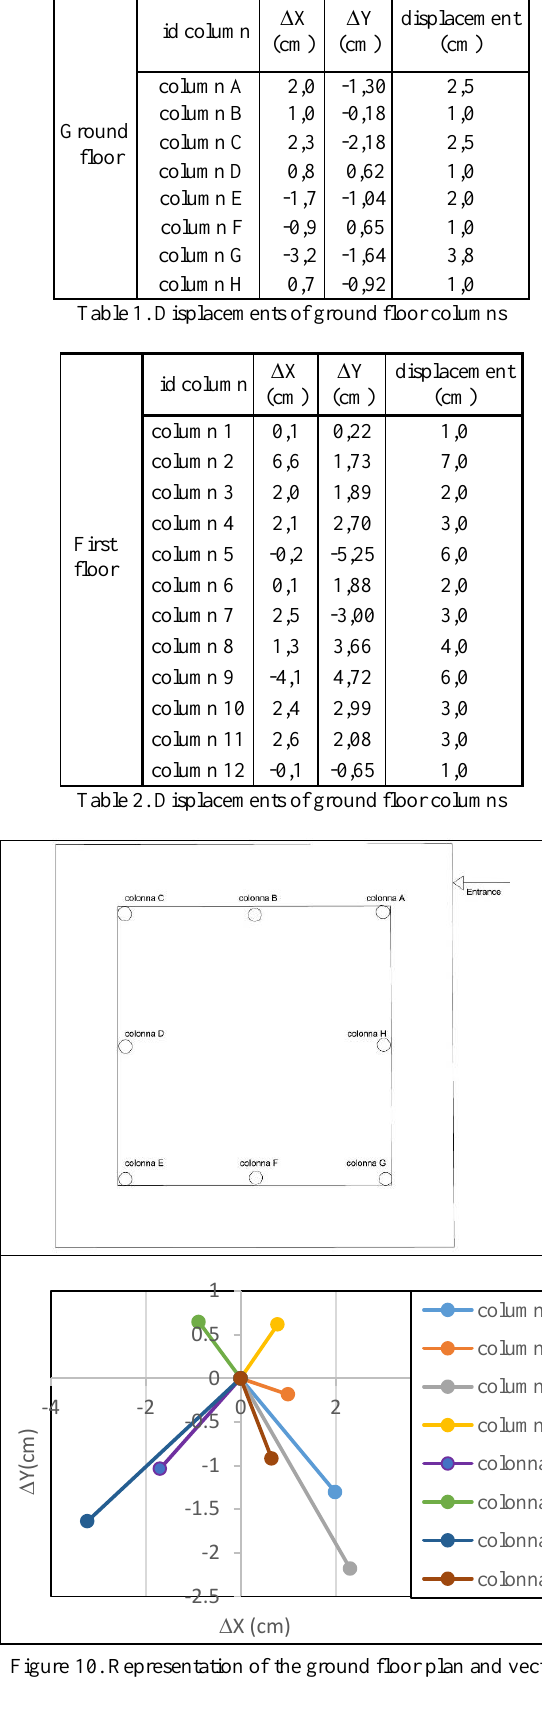
Figure 8. Displacements of A first floor columns